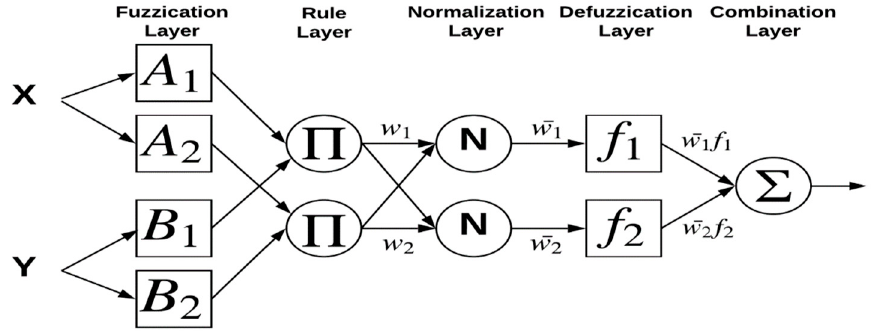
Figure 2. Basic structure of the adaptive network based fuzzy inference system (ANFIS).